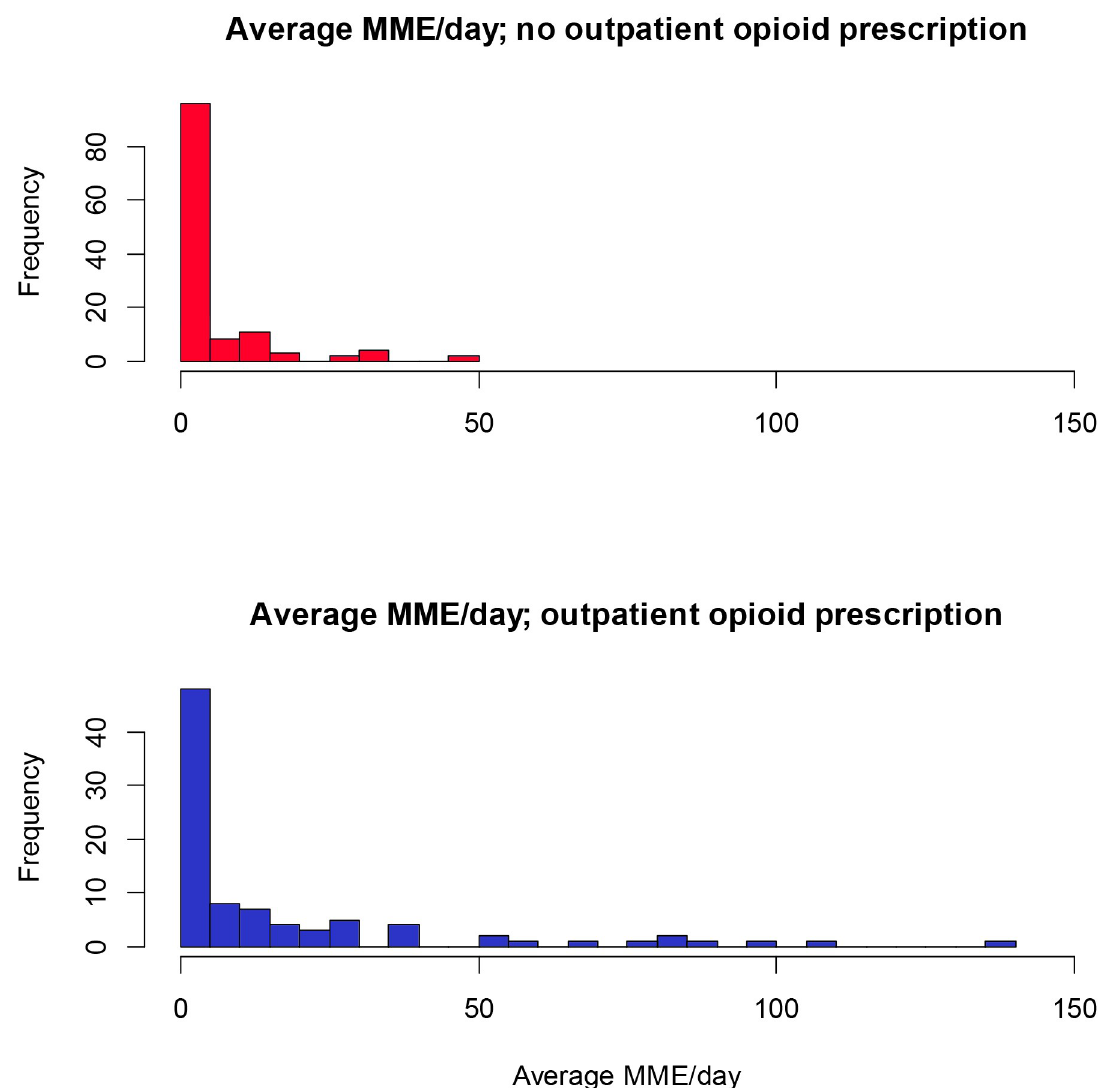
Fig 2. Histogram of average daily opioid use stratified by outpatient prescription of opioids. Histogram demonstrating the frequency of patients by the average morphine milligram equivalent (MME) per day among patients with and without an outpatient opioid prescription. The numerator is the total summed dose, converted into morphine equivalents, divided by the total length of hospitalization; patients on patient controlled analgesia were considered in the highest quartile.